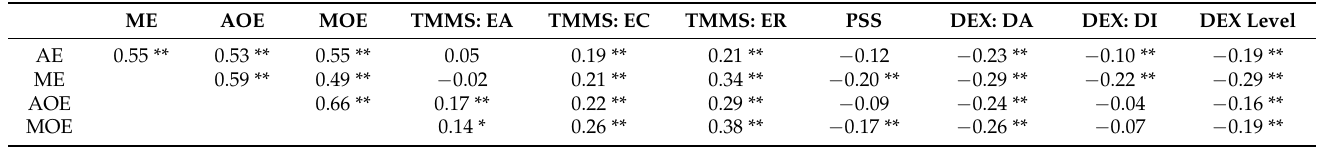
Table 5. Spearman correlation among variables.